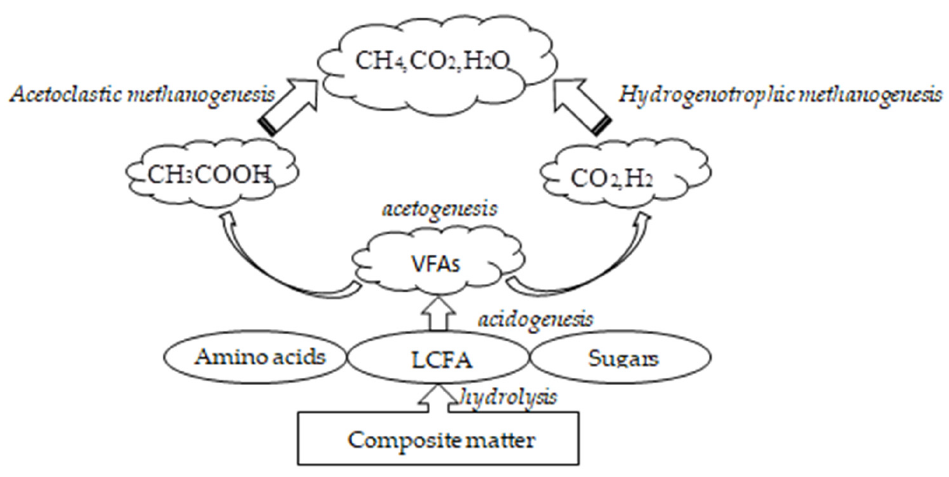
Figure 4. Sequential steps usually considered in AD models .